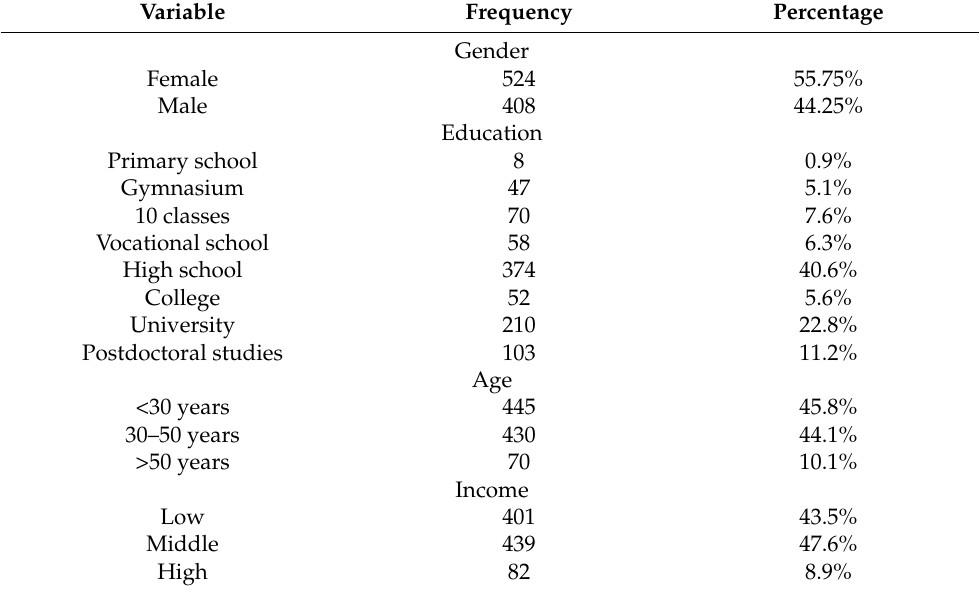
Table 1. Socio-Demographic Characteristics.